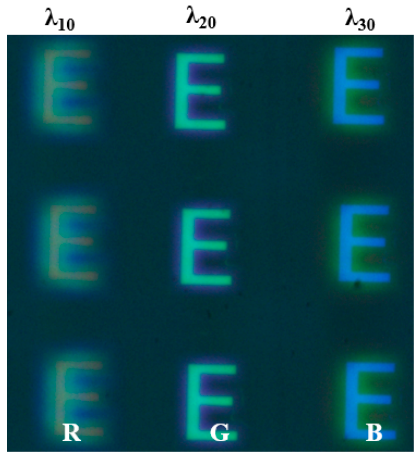
Figure 9. Red, Green and Blue multi-spectral imaging effects.